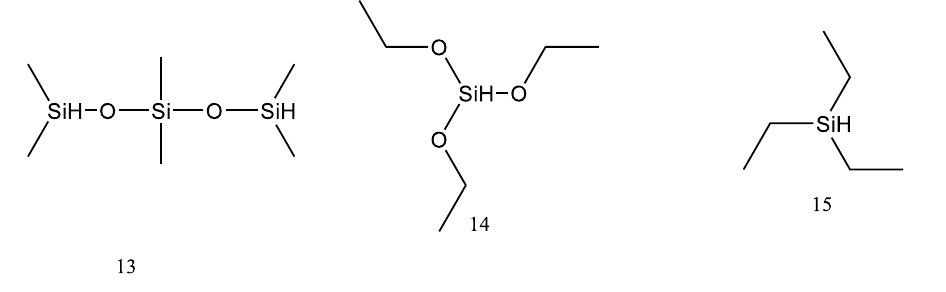
Figure 2. Model organosilicon test compounds.